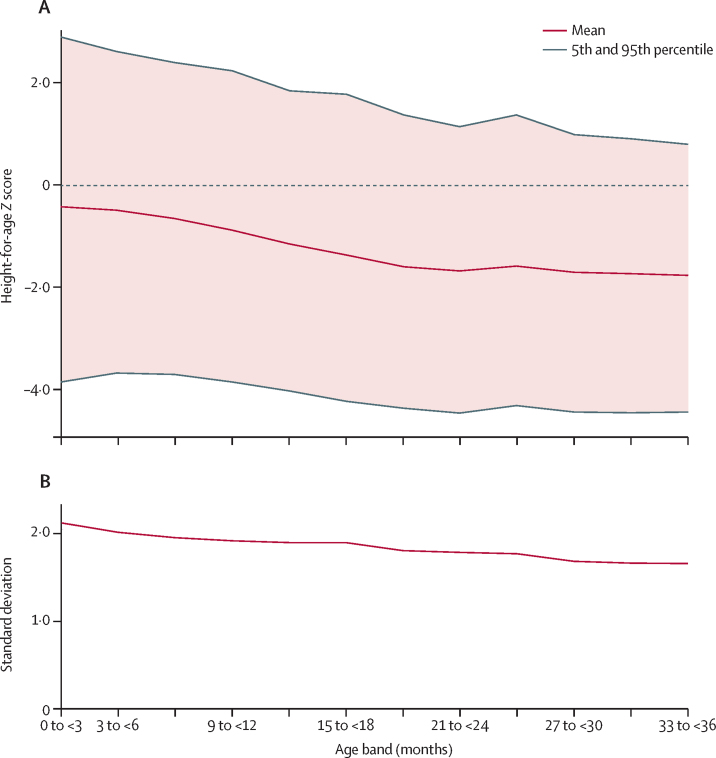
Trends in cross-sectional HAZ distribution parameters for successive 3-month age bandsFigure shows data for 2148 survey-age units. (A) Mean, fifth percentile, and 95th percentile. (B) Standard deviation. HAZ=height-for-age Z score.